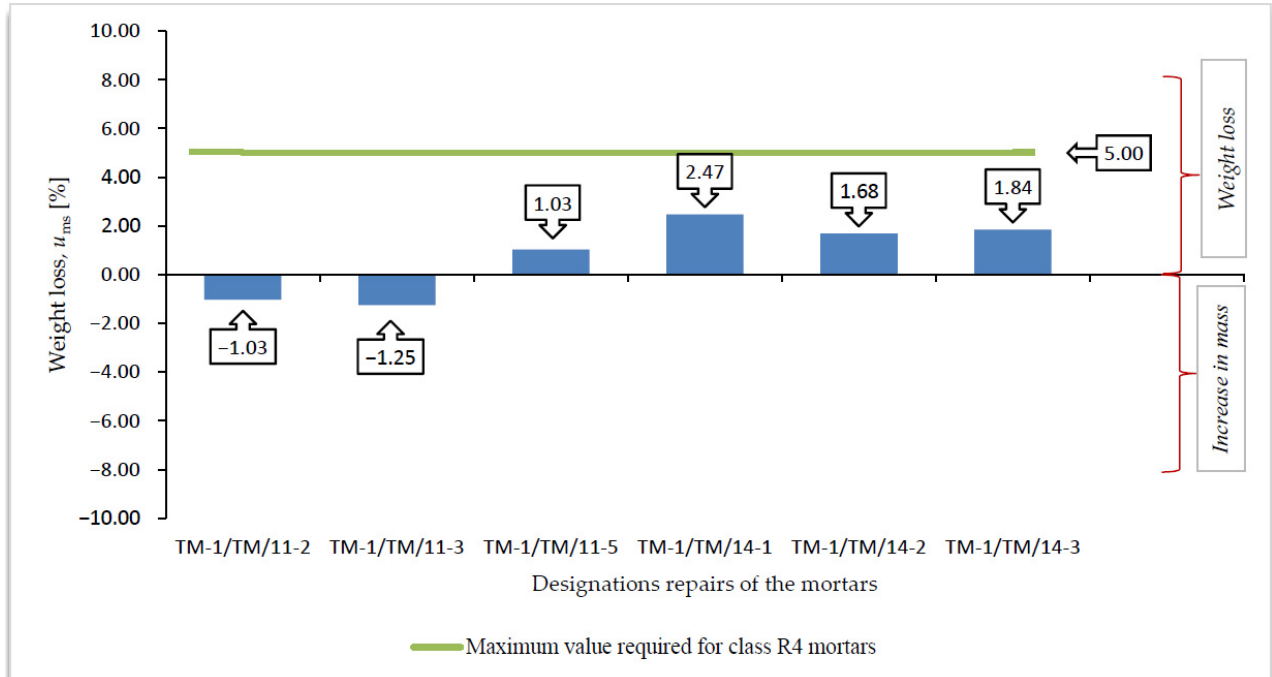
Figure 8. Summary of averages values of weight loss of R4 class mortars after frost resistance testing, according to [19], u m [%].